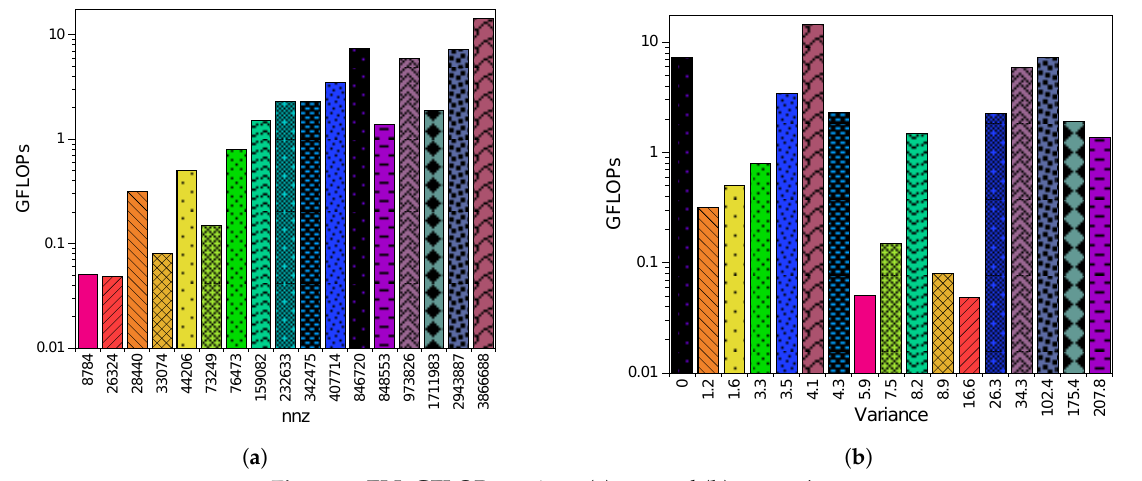
Figure 7. ELL GFLOPs against: ( a ) nnz and ( b ) npr variance .